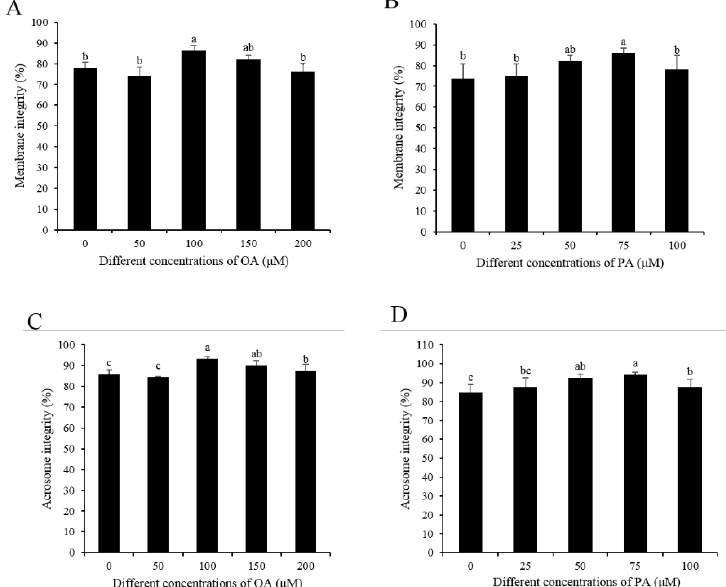
Figure 3. Effects of OA and PA on sperm membrane integrity and acrosome integrity after seven days of preservation: (A and B) membrane integrity; (C and D) acrosome integrity. Values are specified as the mean ± standard deviation (SD). Columns with different lowercase letters differ significantly ( p ＜ 0.05).